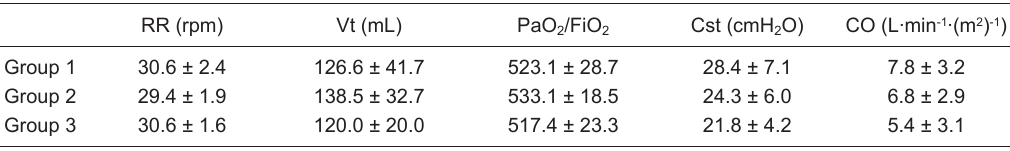
Table 1. Initial characteristics of the animals